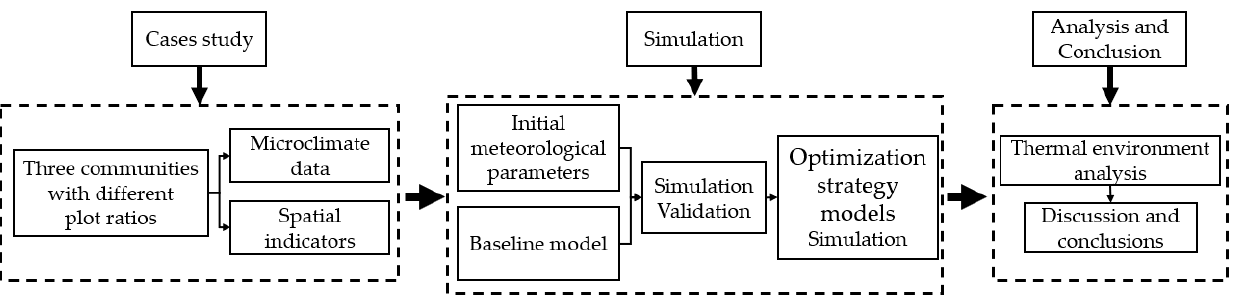
Figure 1. The schematic of the study workflow.